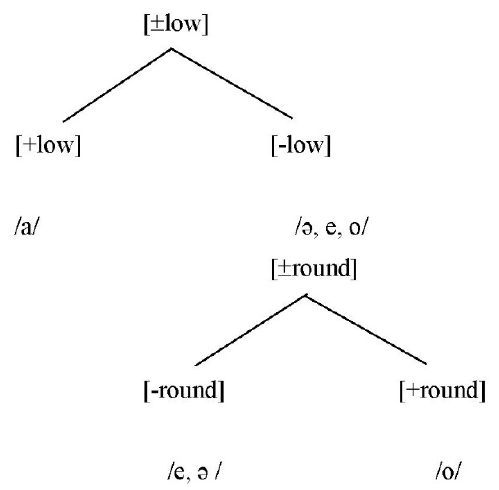
Figure 16. The Mandarin contrastive hierarchy applied to English vowels.